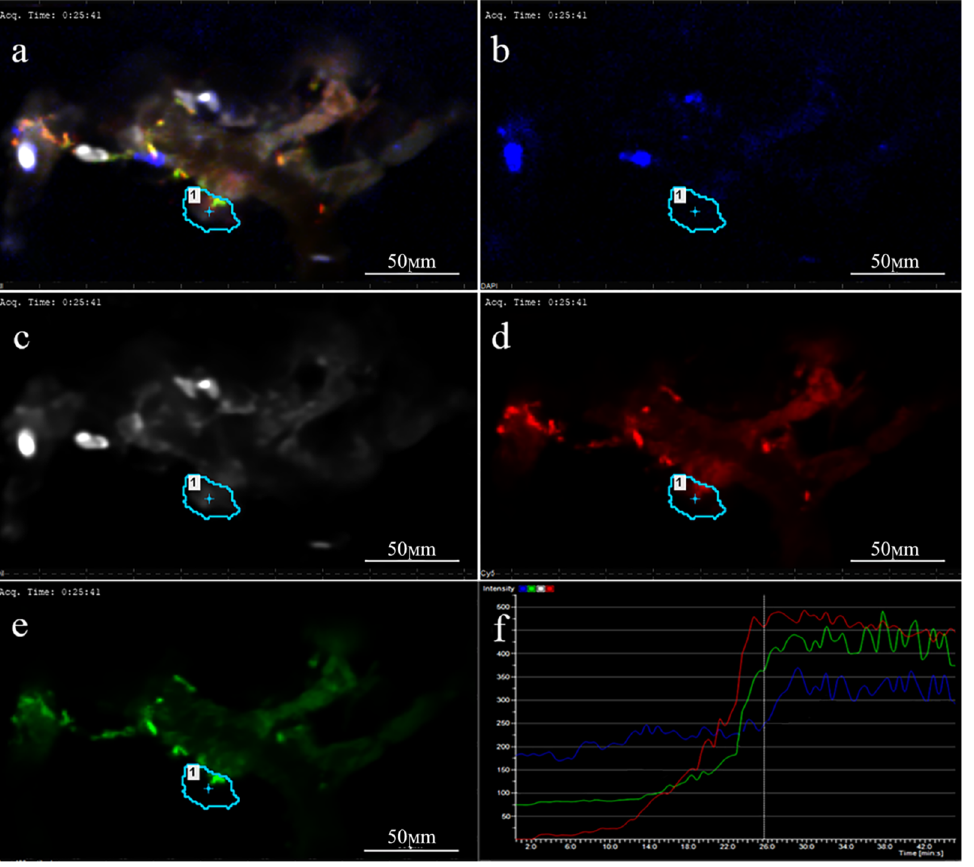
Figure 10. Extravasation of hMNP and PLGA NP through macroleakages in tumor vasculature and peritumoral space in 4T1 subcutaneous tumor (0–45 min after injection of both NP). ( a ) Merged image; ( b ) Ly6G-positive neutrophils; ( c ) CD45-PE; ( d ) PLGA-Cy5 NP; ( e ) hMNP-FITC; ( f ) fluorescence intensity profiles (Y-axis) measured in dynamics. Scale bar—50 µm.